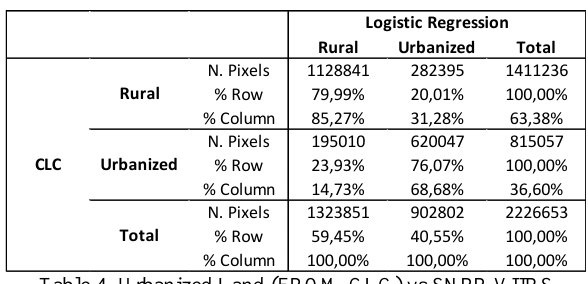
Table 4. Urbanized Land (FROM-GLC) vs SNPP-VIIRS (Shenzhen)